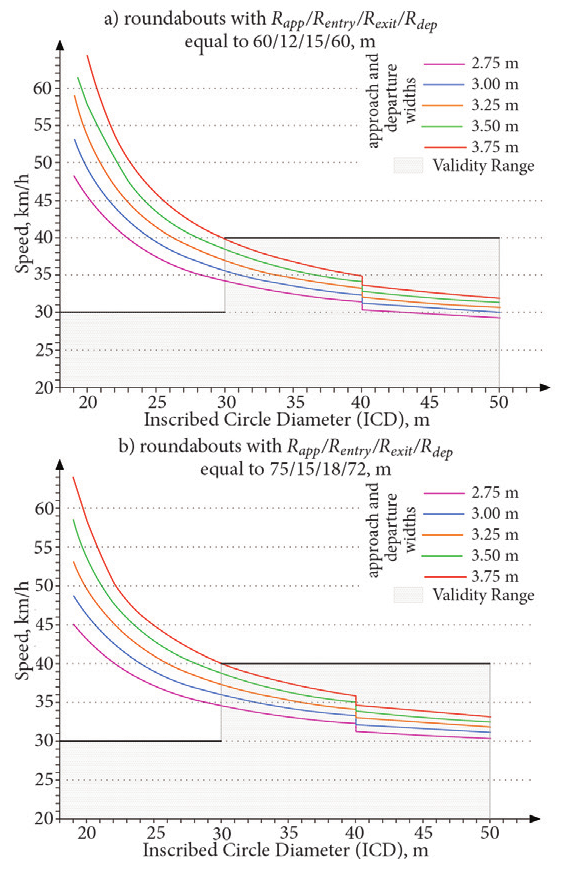
Figure 4. Checking the entry path radius